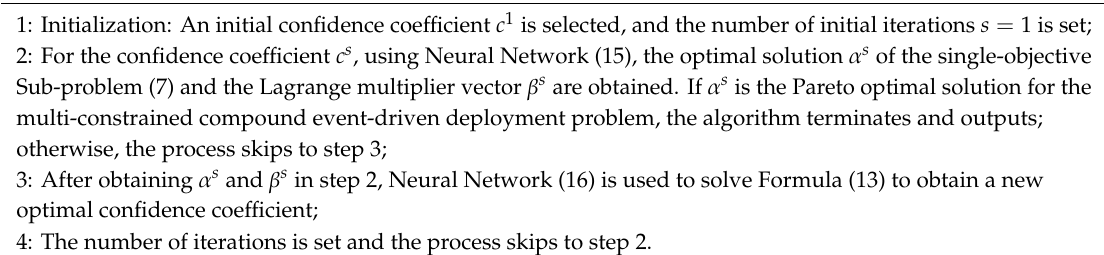
Algorithm 1 Compound Event-Driven Deployment Algorithm Based on the Collaborative Neural Network Strategy.